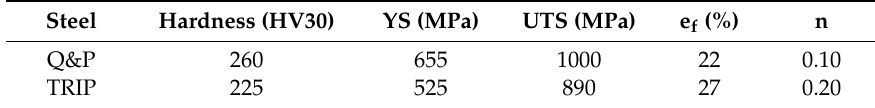
Table 2. Main mechanical properties of Q&P and TRIP steels. HV30: Vickers hardness; YS: yield strength; UTS: ultimate tensile strength; e f : elongation at fracture; n: strengthening